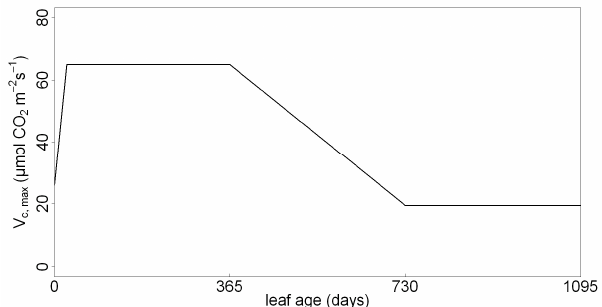
Fig. 1. In ORCHIDEE, leaf photosynthetic capacity ( V c,max ) is de- Figure 1. In ORCHIDEE, leaf photosynthetic capacity (V c,max ) is determined as a termined as a function of leaf age. The slope of the curve is deter- function of leaf age. The slope of the curve is determined by a critical leaf age mined by a critical leaf age parameter, which is set to 730 days for parameter, which is set to 730 days for tropical evergreen forests. tropical evergreen